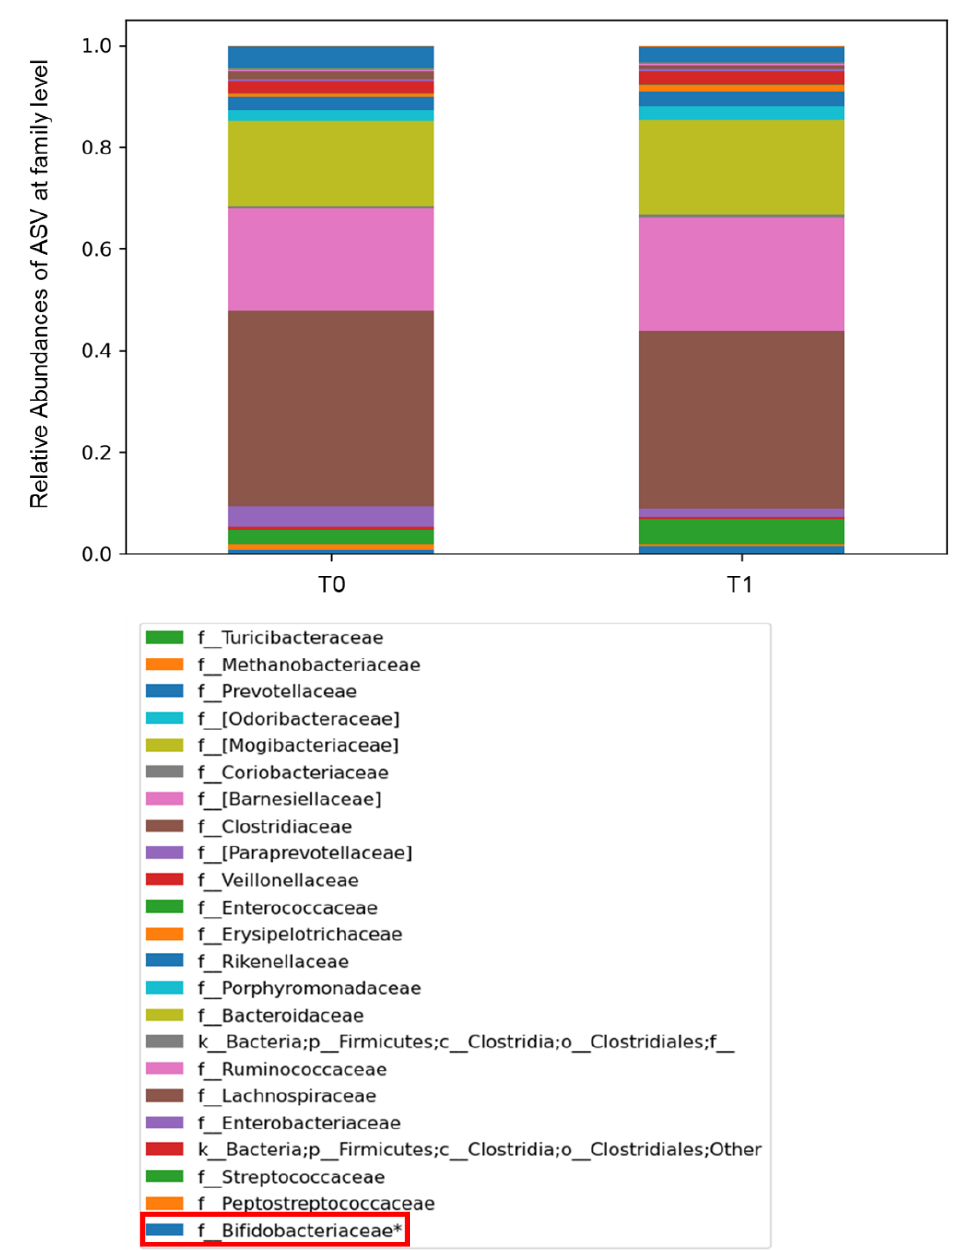
Figure 3. Histograms representing the relative abundancies of Amplicon Sequence Variant (ASV) distributions in the gut microbiota of patients at T 0 and T 1 , represented at taxonomic family level (L5). The bacterial families were compared by Kruskal–Wallis test. The box in red refers to the family Bifidobacteriaceae, relevant for the composition of the administered probiotic, including Bifidobacterium , and filtered by statistical significance (* p value < 0.001). At the taxonomic genus level (L6), Ruminococcus , Oscillospira , Streptococcus and Bifidobacterium were more abundant at T 1 than at T 0 , with Bifidobacterium being statistically significant ( p < 0.05) (Figure